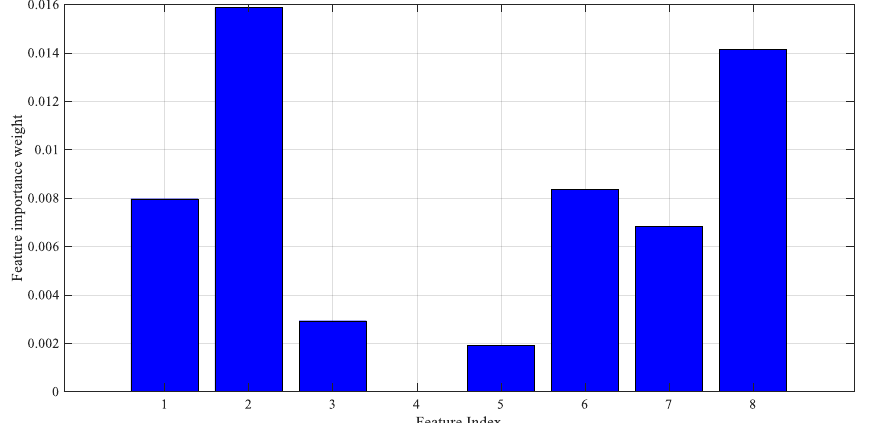
Figure 2. Importance weight of features in the PIMA dataset.